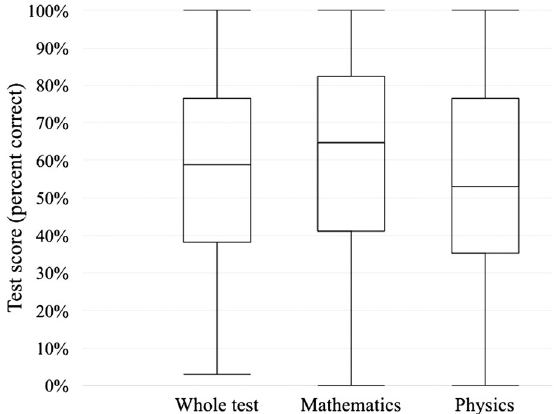
FIG. 1. Box plots of students ’ scores for the whole test, for the mathematics part and for the physics part.